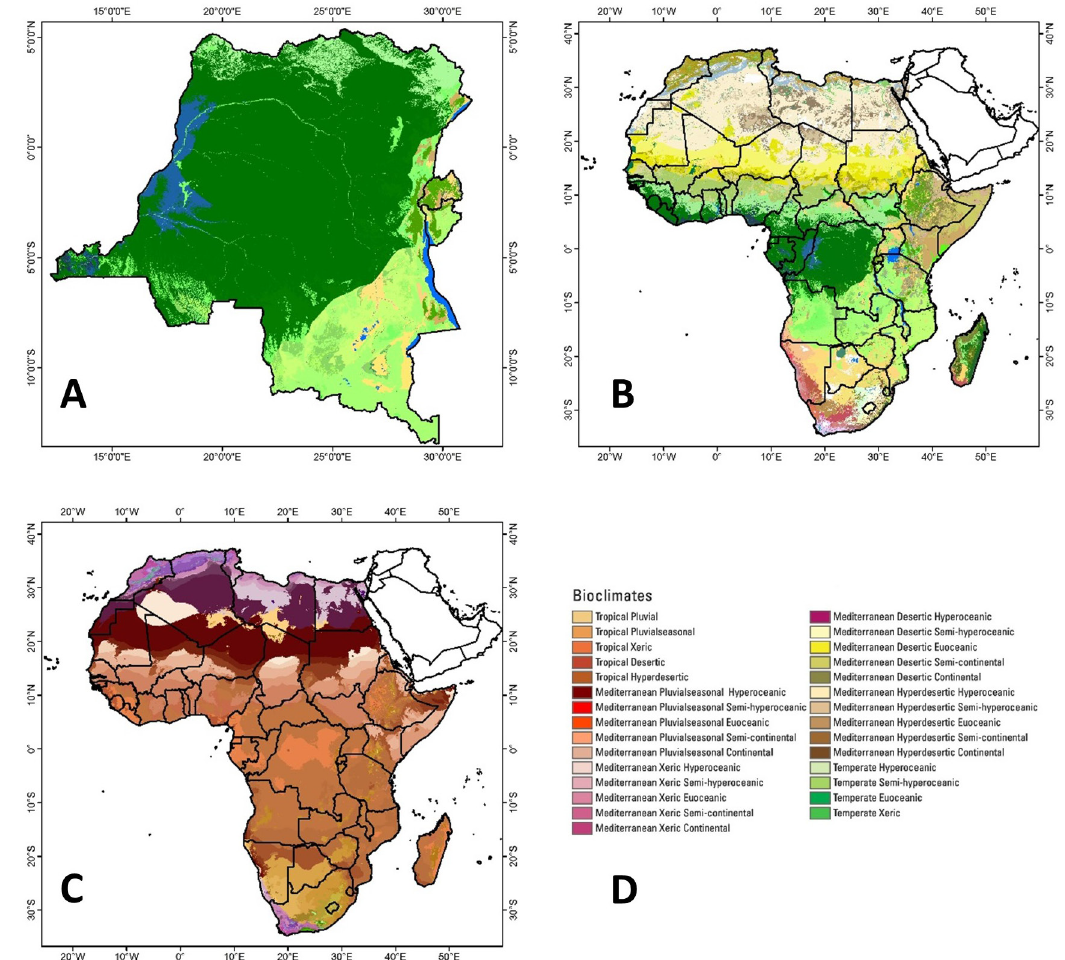
Fig. 2. A . Vegetation map of the CRB. B . Vegetation map of Africa (Blue = Central Congo Basin Swamp Forest or Lakes, Dark green = Forest to Open Woodland, Light green = Shrubland or Grassland, Brown = Desert or Semi-Desert). C . Bioclimates map. D . Colour codes used in Figure 2C (all modified after Sayre et al.